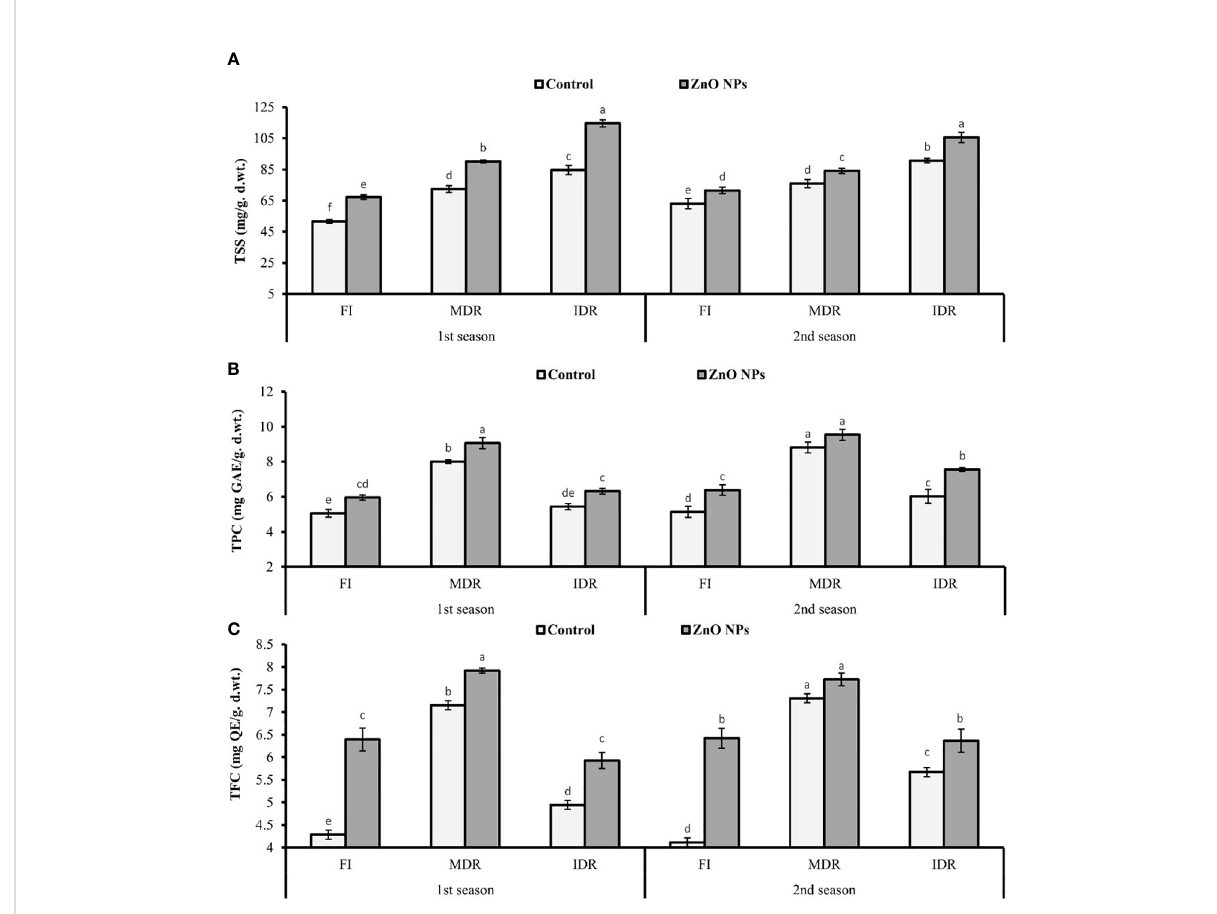
FIGURE 3 Effect of foliar application of ZnO nanoparticles (100 ppm) on (A) total soluble sugars, (B) total phenolic content, and (C) total fl avonoid content in the fi rst and second seasons in full irrigation, moderate drought regimes, and intensive drought regime plants. The graph values are the mean ± SE of four replicates. Bars exhibited with different alphabets indicate the signi fi cant difference between samples by least signi fi cant difference ( p ≤